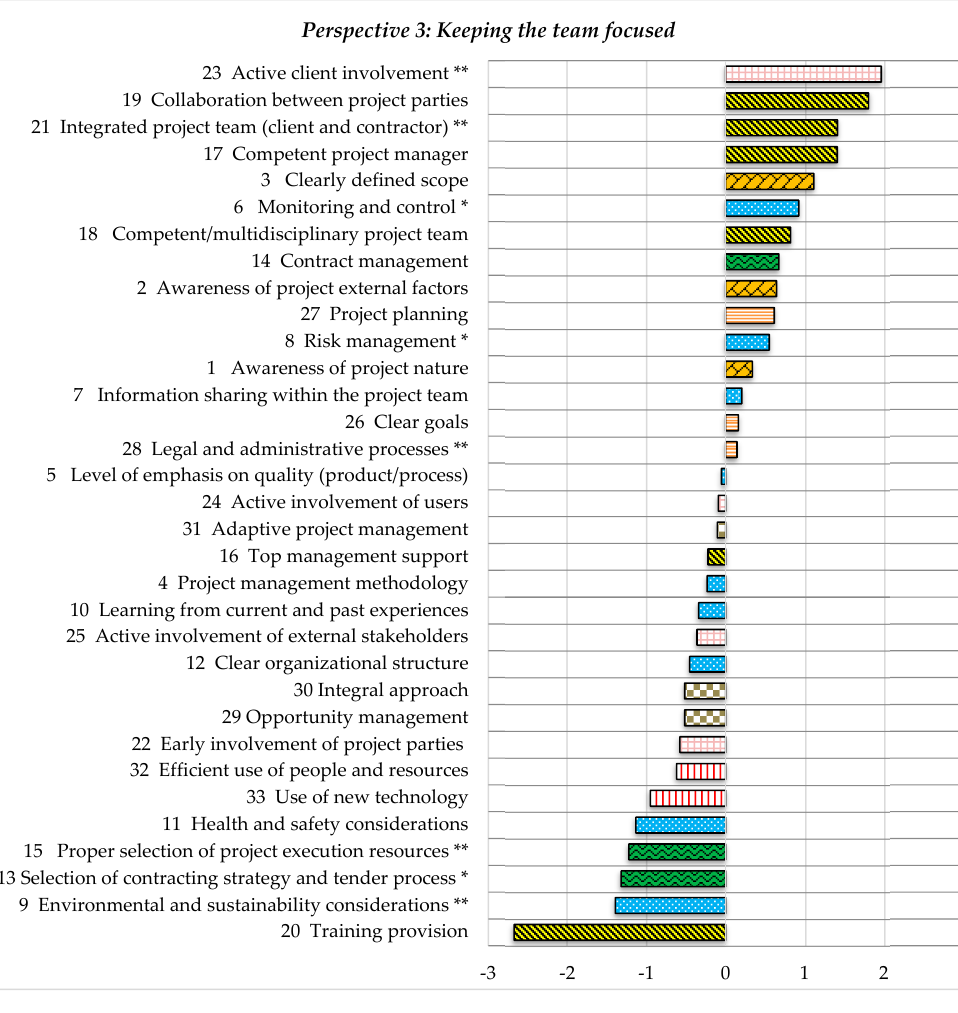
Figure 4. Ranking of success factors for keeping the team focused perspective (P3). * The factor is distinguishing at p < 0.05; ** The factor is distinguishing at p < 0.01.